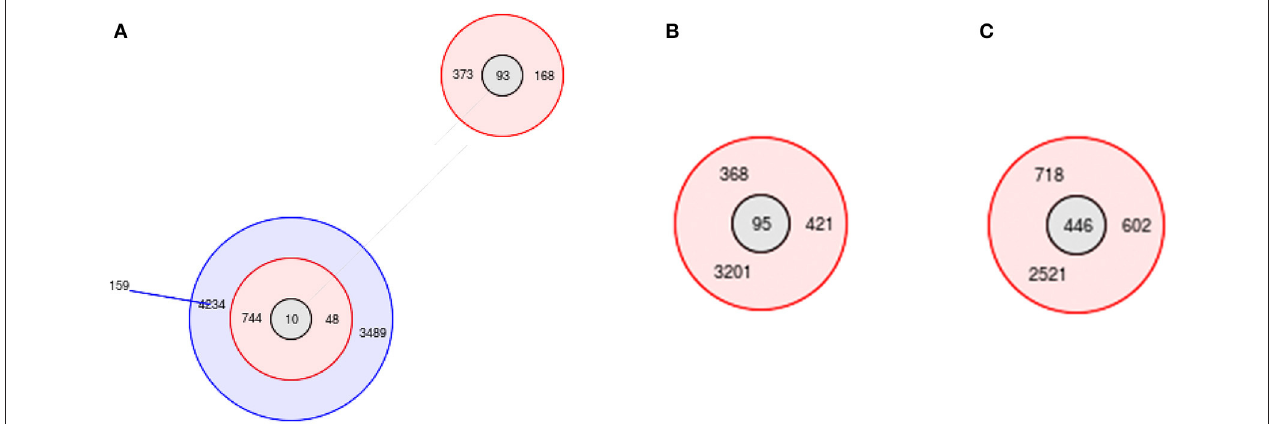
FIGURE 9 | MLST profiles of E.coli isolates. (A) group 2; (B) group 4; (C) group